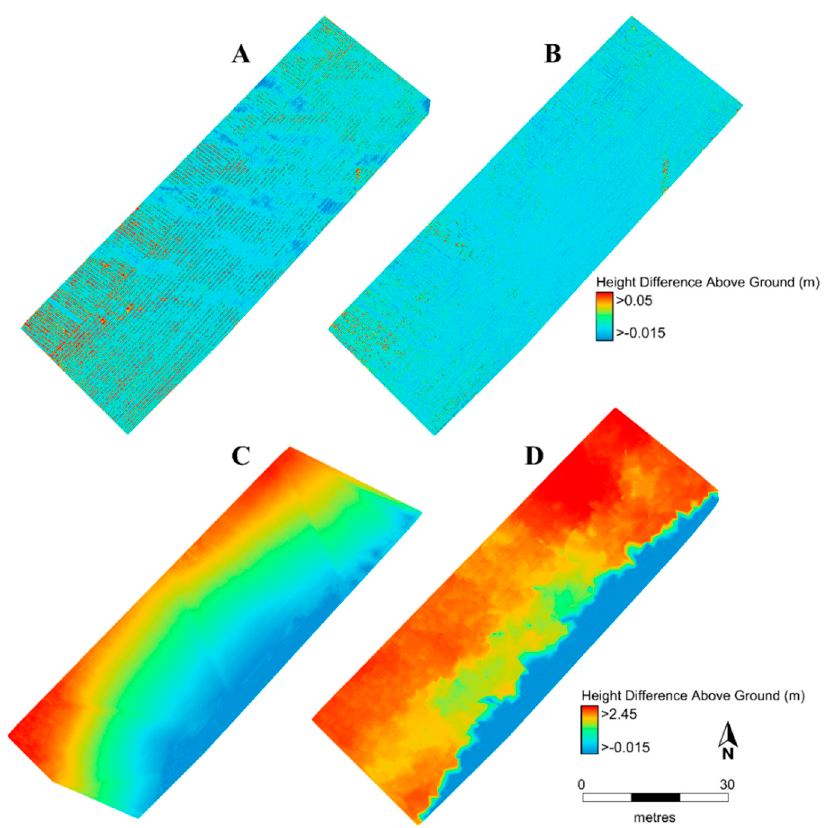
Figure 2. Rasterized height above the reference ground surface of the points classified as ground by the CSF ( A ) and MSBF ( B ) classifications of the very low corn site, and the CSF ( C ) and MSBF ( D ) classifications of the high corn site.